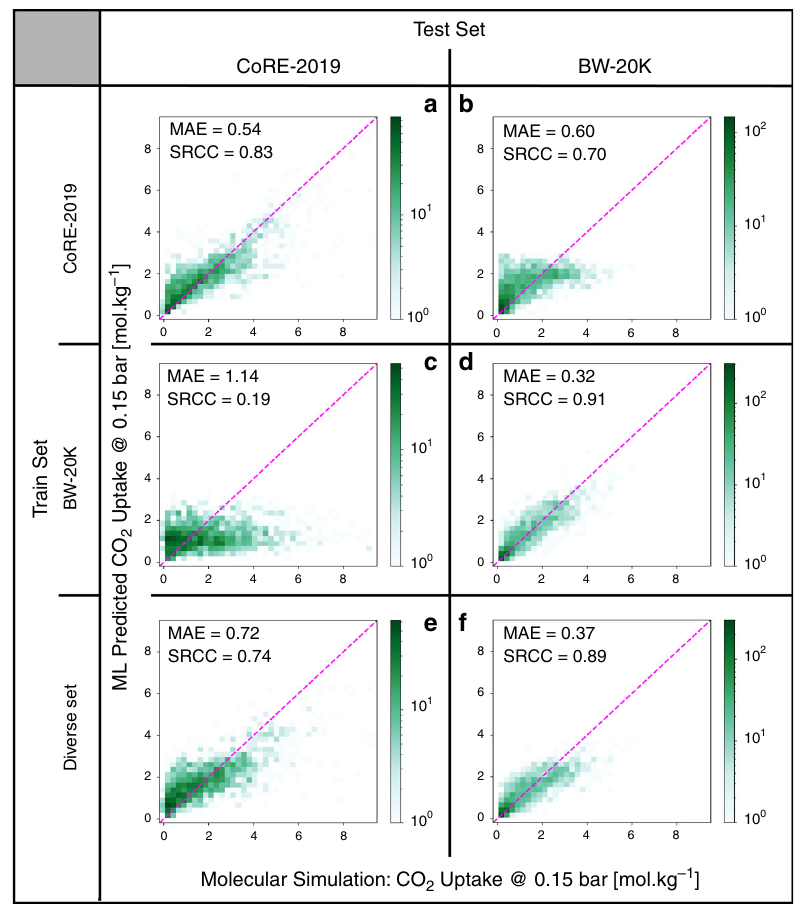
Fig. 5 Impact of diversity in training data on transferability of models. The parity plots of random forest models using full features; rows and columns correspond to the training and test sets, respectively. The dashed lines represent the parity. The size of training sets is equal in all cases. The same structures were used as test sets in each column. The diverse set was selected using the MaxMin 47 algorithm using all geometric and chemical descriptors. The colour bars show the number of structures in each cell of the